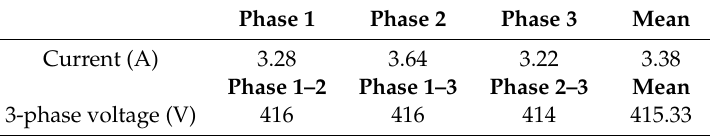
Table 5. Extraction current and voltage measurements.